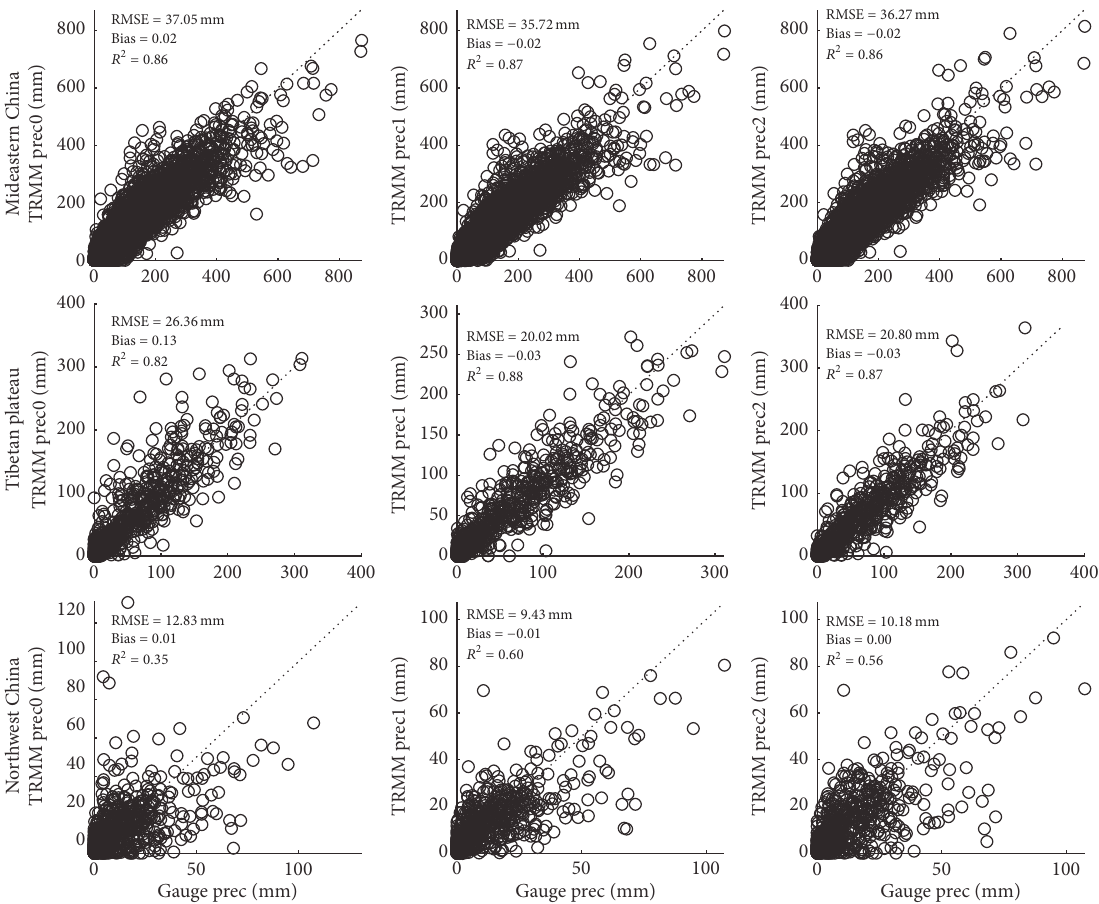
Figure 7: Scatterplots of monthly gauge precipitation versus original/corrected TRMM precipitation in the three regions at station scale.